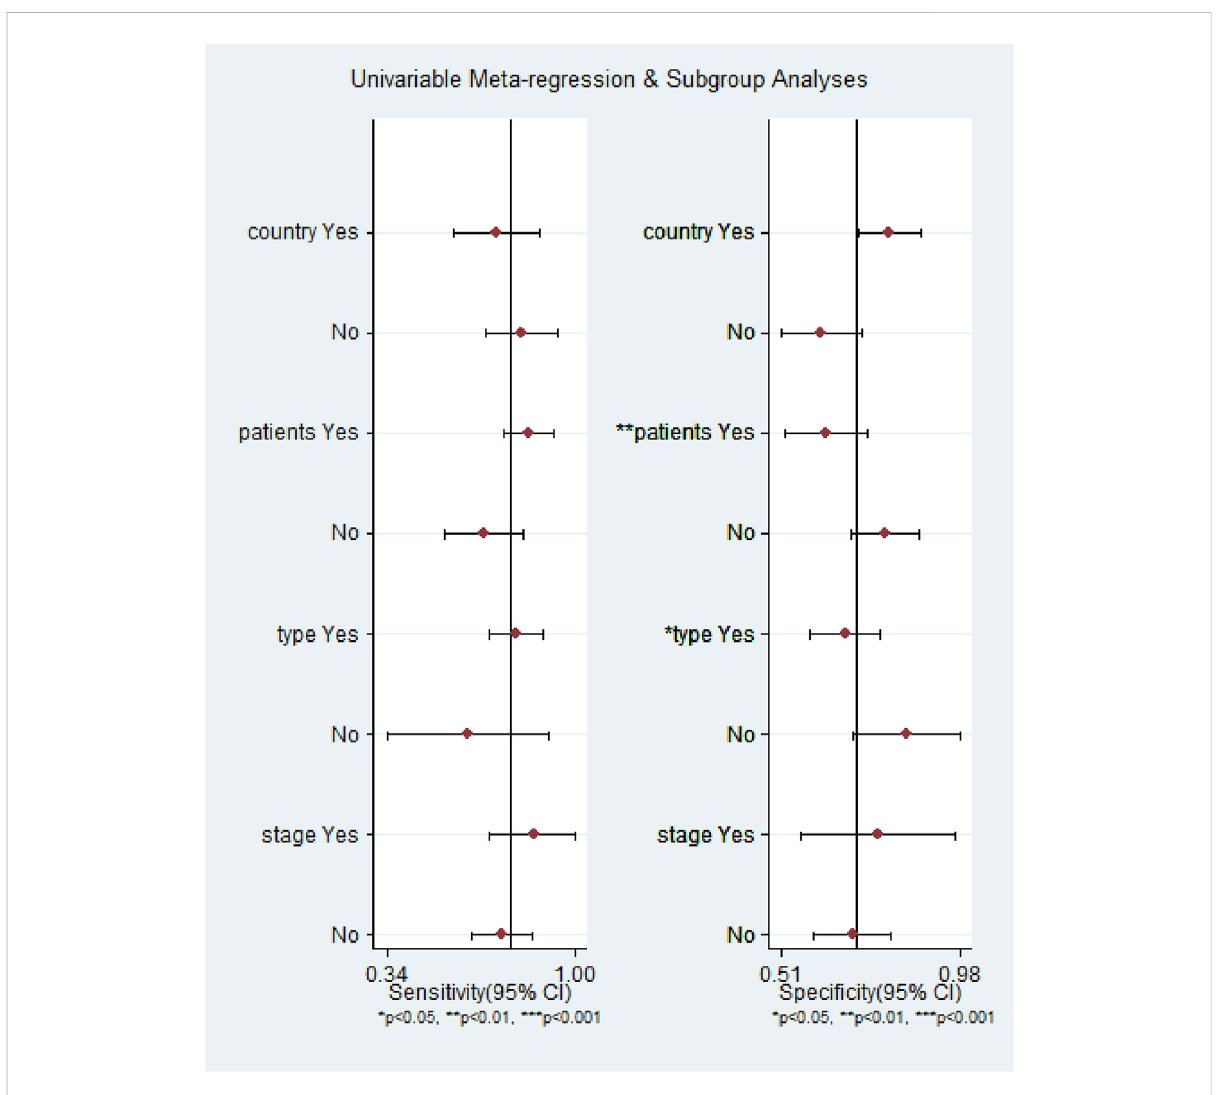
FIGURE 8 Meta-regression analysis to detect the source of heterogeneity for the miR-17 – 92 cluster in the diagnosis of hepatocellular